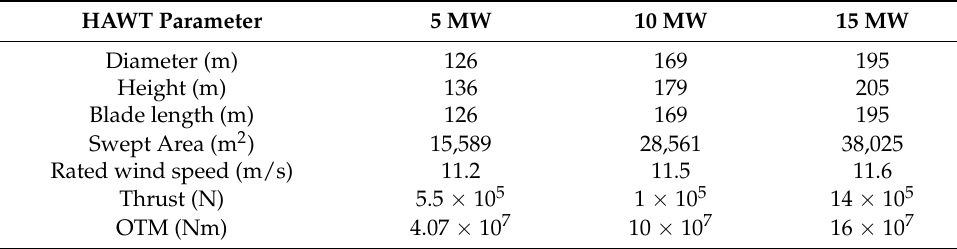
Table A3. H-Rotor turbine